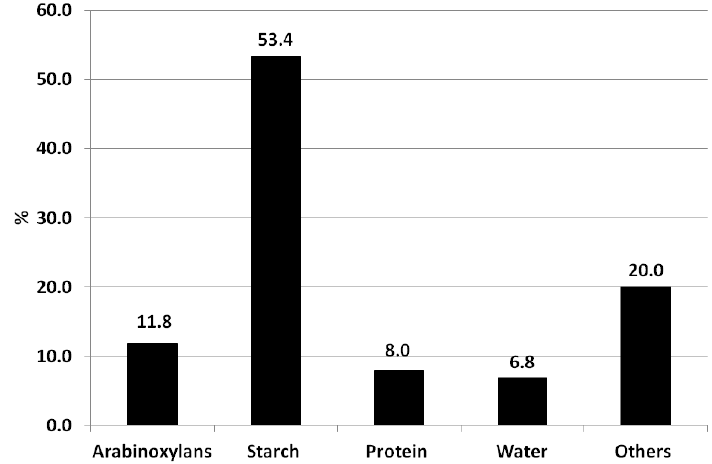
Figure 1. Chemical composition of arabinoxylan-enriched material provided by Henan Lianhua Monosodium Glutamate Group Co.